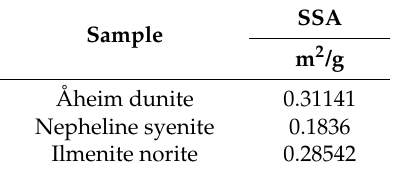
Table 3. Specific surface areas (SSA) determined by